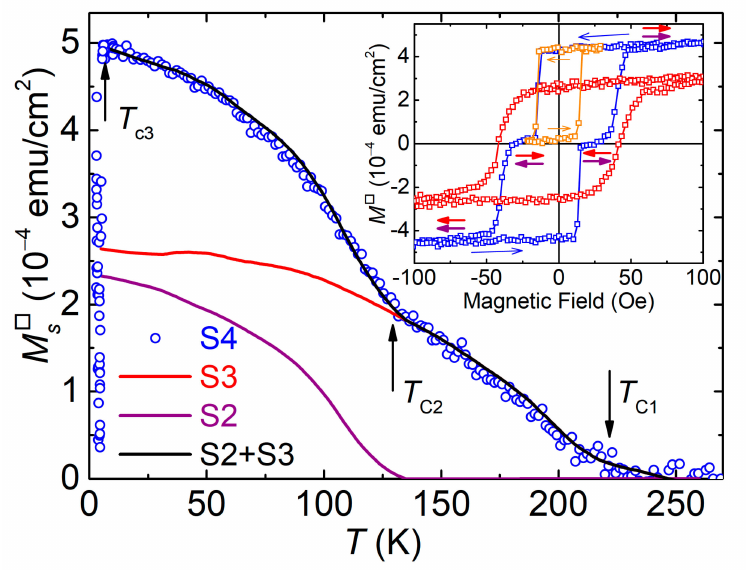
Figure 4. The saturation magnetic moment per unit area as a function of temperature for the pseudo-spin-valve MgO/Pd 0.96 Fe 0.04 /VN/Pd 0.92 Fe 0.08 heterostructure S4 measured with an applied magnetic field of 500 Oe. The black solid line is a sum of the magnetic moments of Samples S2 and S3 in the temperature range above the superconducting transition. The inset shows magnetic hysteresis loops for the same structure measured at 6 K: blue squares, major hysteresis loop of the S4 sample; orange squares, minor hysteresis loop of the S4 sample; red squares, hysteresis loop of the S3 sample. Pairwise purple and red arrows depict magnetic moment directions of the Pd 0.92 Fe 0.08 and Pd 0.96 Fe 0.04 layers, respectively. The ferromagnetic transition temperatures are T C 1 ≈ 220 K for Sample S3 and T C 2 ≈ 127 K for Sample S2, while the superconducting transition temperature T c 3 = 5.42